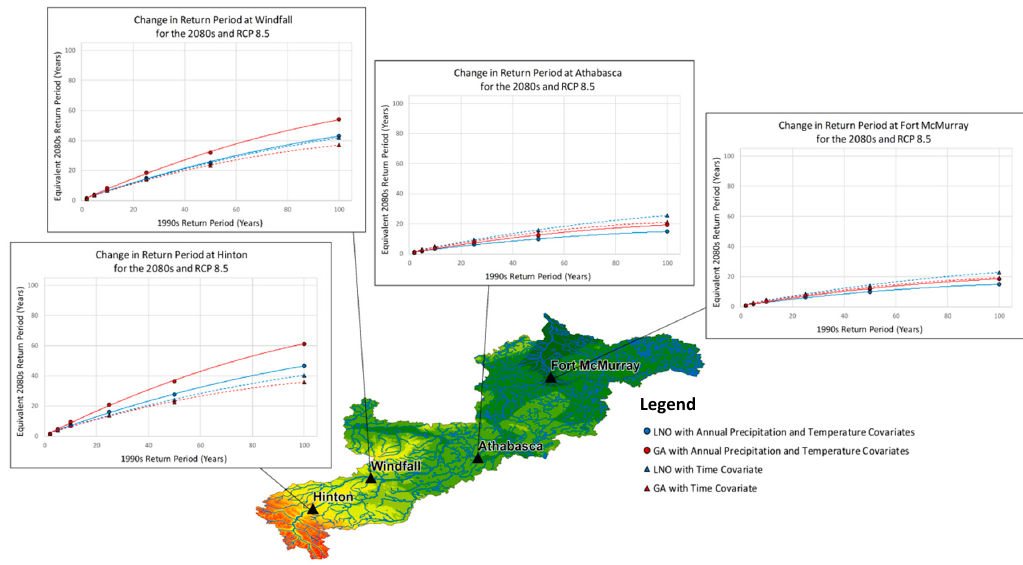
Figure 8. Results of non-stationary analysis - ensemble projected changes in flood events of different return periods corresponding to the 1990s baseline and the 2080s future periods corresponding to the RCP8.5 emissions scenarios. The analysis is conducted on AMS using time, as well as temperature and precipitation covariates.